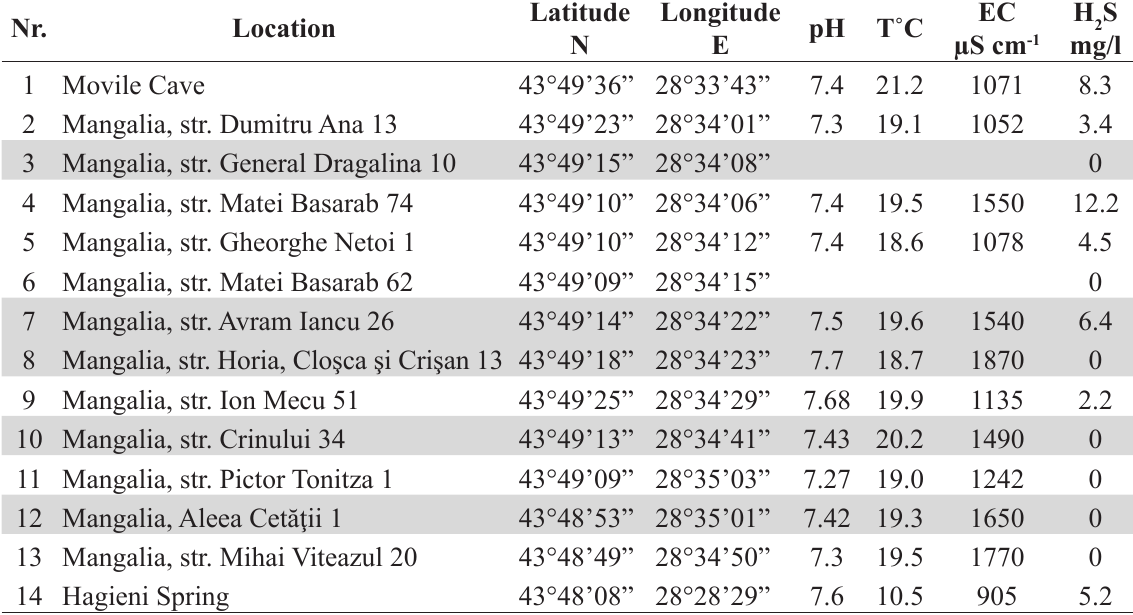
Table 2. List of sampling locations with their geographic position and physico-chemical characteristics. The numerals in the first column relate to the location numbers in Fig. 1. The specimens dissected and analyzed for this study were selected from the locations highlighted in